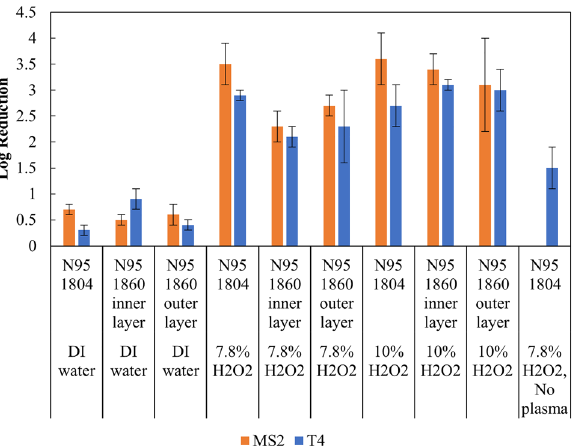
Figure 2. Decontamination efficiency of MS2 and T4 on N95 respirators treated by different compositions of PAM. N95 1804 treated in 7.8% hydrogen peroxide mist without plasma was not tested on MS2. All